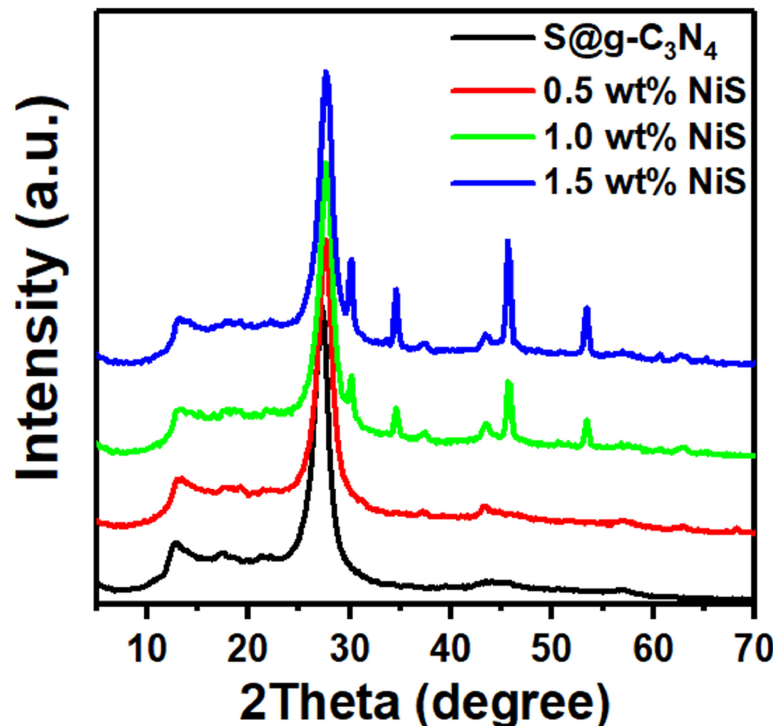
Figure 1. XRD data of S@g-C 3 N 4 and NiS-g-C 3 N 4 nanocomposites.